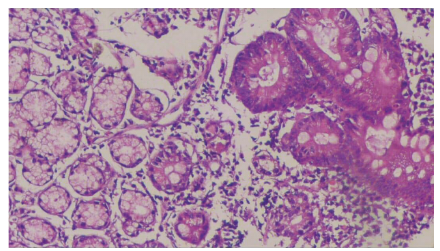
Figure 2: Histopathological pattern of atrophic gastritis.